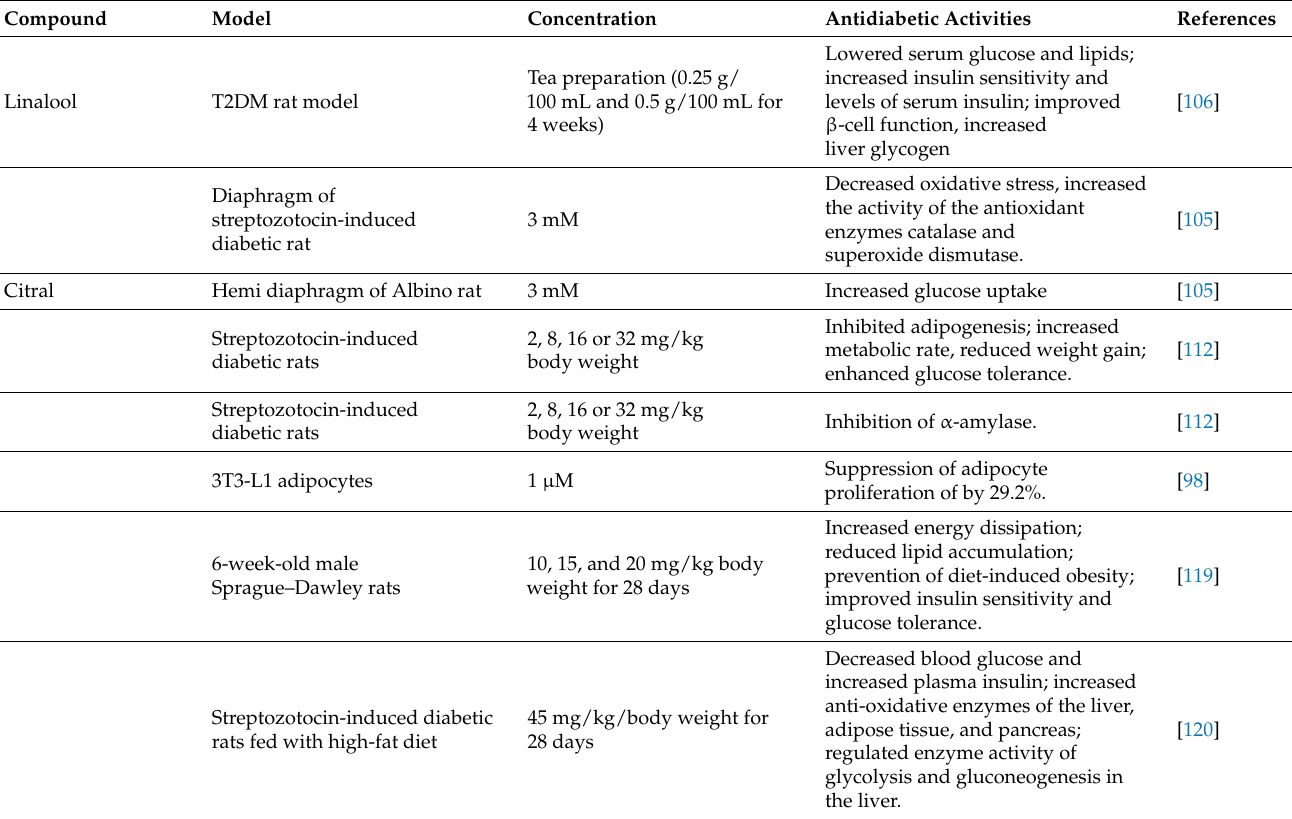
Table 1. Antidiabetic effects of acyclic